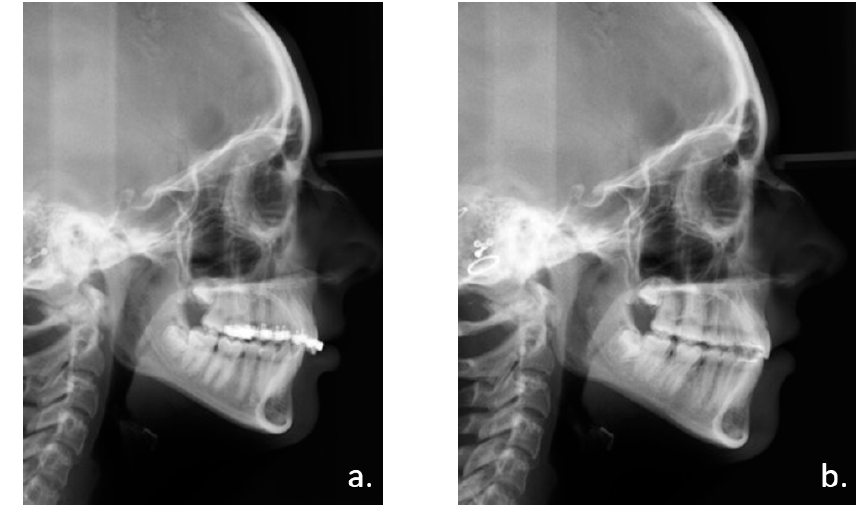
Figure 4. Lateral skull view (a.) before and (b.) after treatment with IMDO.